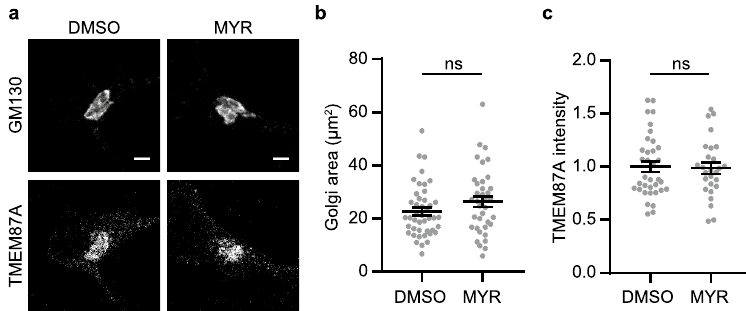
Figure 7. Addition of myriocin (MYR) to Vti1a/b DKO neurons does not rescue Golgi area or TGN staining intensity. ( a ) Representative examples of neurons immunostained for GM130 and TMEM87A, after 1 week treatment with 0.1% DMSO or 50 μM Myriocin. ( b ) Golgi area based on GM130 is not affected by myriocin treatment (DMSO: n = 44; MYR: n = 37). Mann Whitney test: ns, p = 0.1593. ( c ) TMEM87A normalized staining intensity is not affected by myriocin treatment (DMSO: n = 35; MYR: n = 27). Mann Whitney test: ns, p = 0.8546. Bars show mean ± SEM. Detailed statistics are shown in Supplementary Table 1. Scale bar is 3